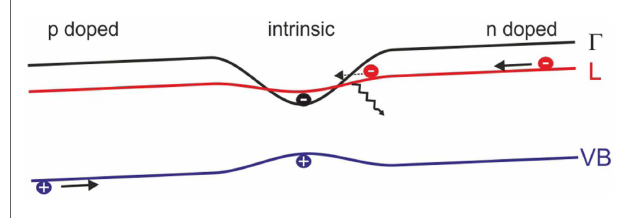
FiGURe 14 | Schematic of the band structure of a forward biased pin strained Ge bridge diode where the intrinsic layer and strained region overlap